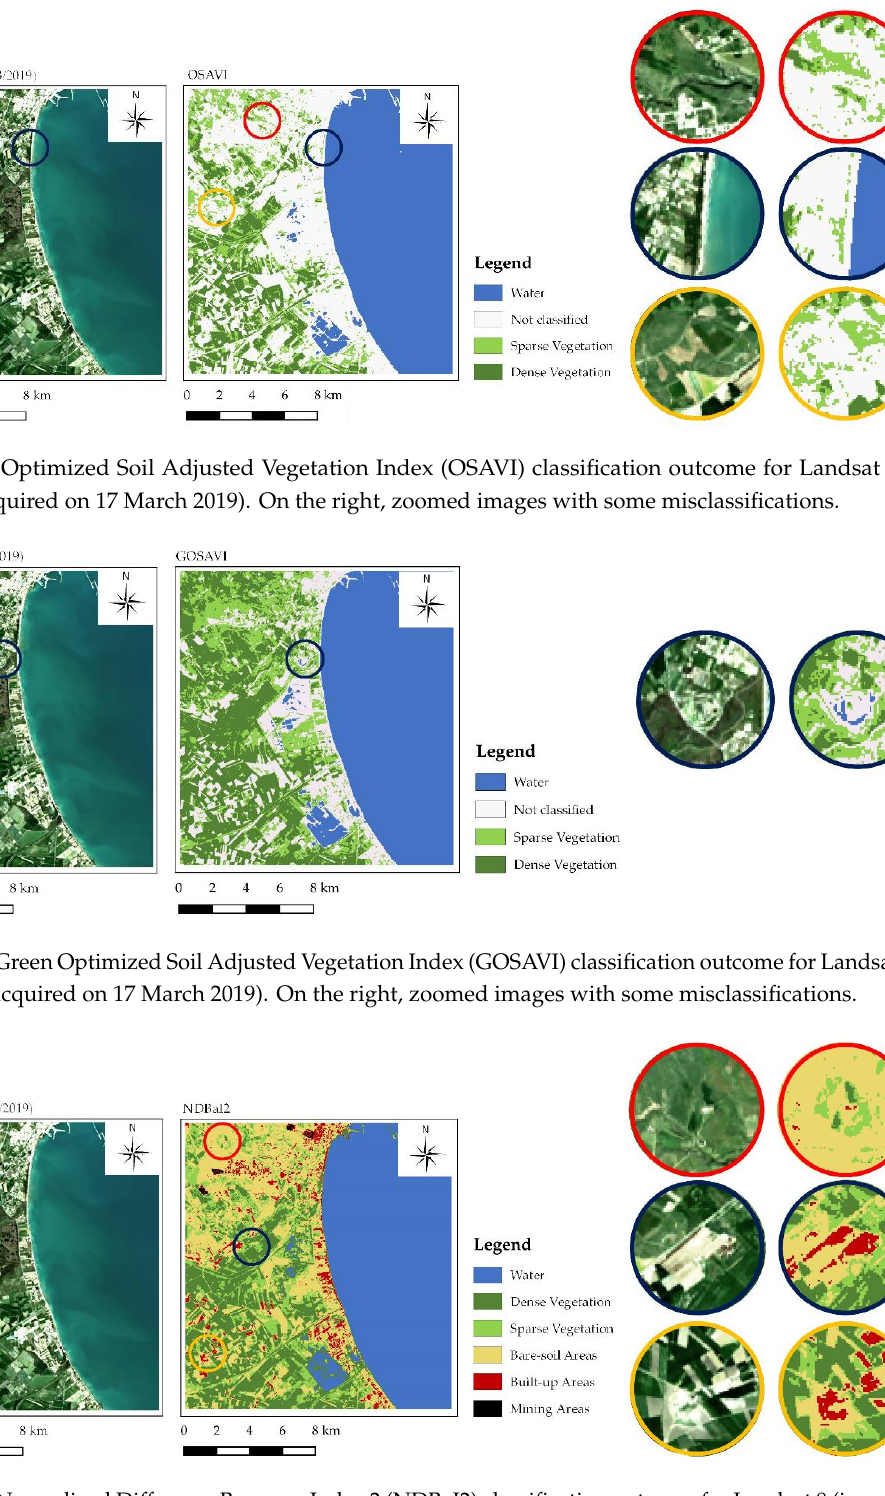
Figure 7. SwirTiRed index (STRed) classification outcome for Landsat 5 (image acquired on 27 March 2011). On the right, zoomed images with some misclassifications.